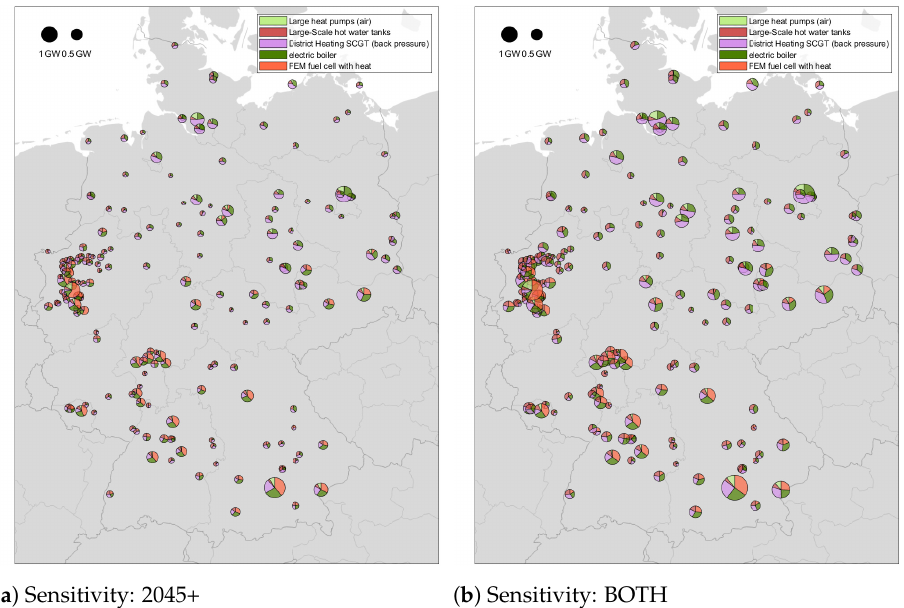
Figure 13. Comparison of district heating technologies with their output capacity: due to higher demand, overall expansion increases.